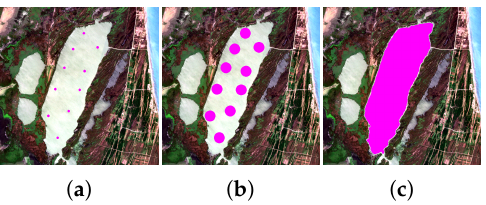
Figure 2. The pink regions denote the unlabeled samples used in our ablation experiments; centered on each of the in situ sampling positions with ( a ) a disk of diameter 11 pixels, ( b ) a disk of diameter 45 pixels, and ( c ) the entire lake surface, yielding 28,160, and 503,040, and 2,364,928 unlabeled samples in 32 images,